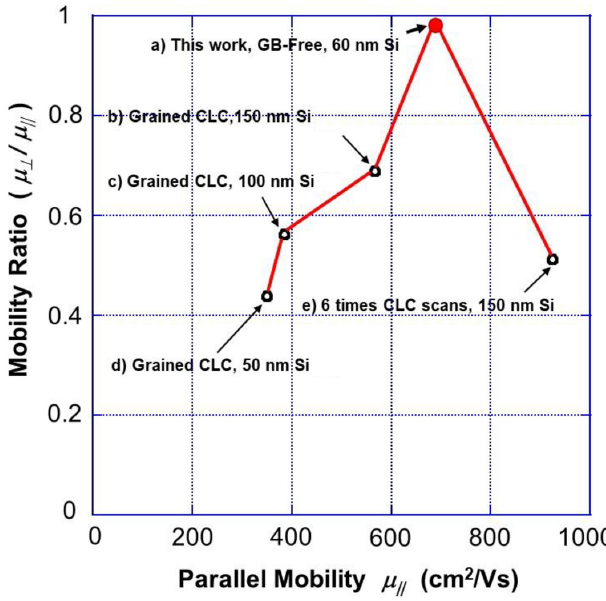
Figure 14. Ratio of the maximum mobility of the perpendicular TFTs to the parallel TFTs as a function of the maximum mobility of the parallel TFTs. The TFTs with the maximum mobility were compared in various thin-film crystallization technologies using the scanned crystallization from the melt [9,12]. (a) this work, (b–d) in [9], (e) in